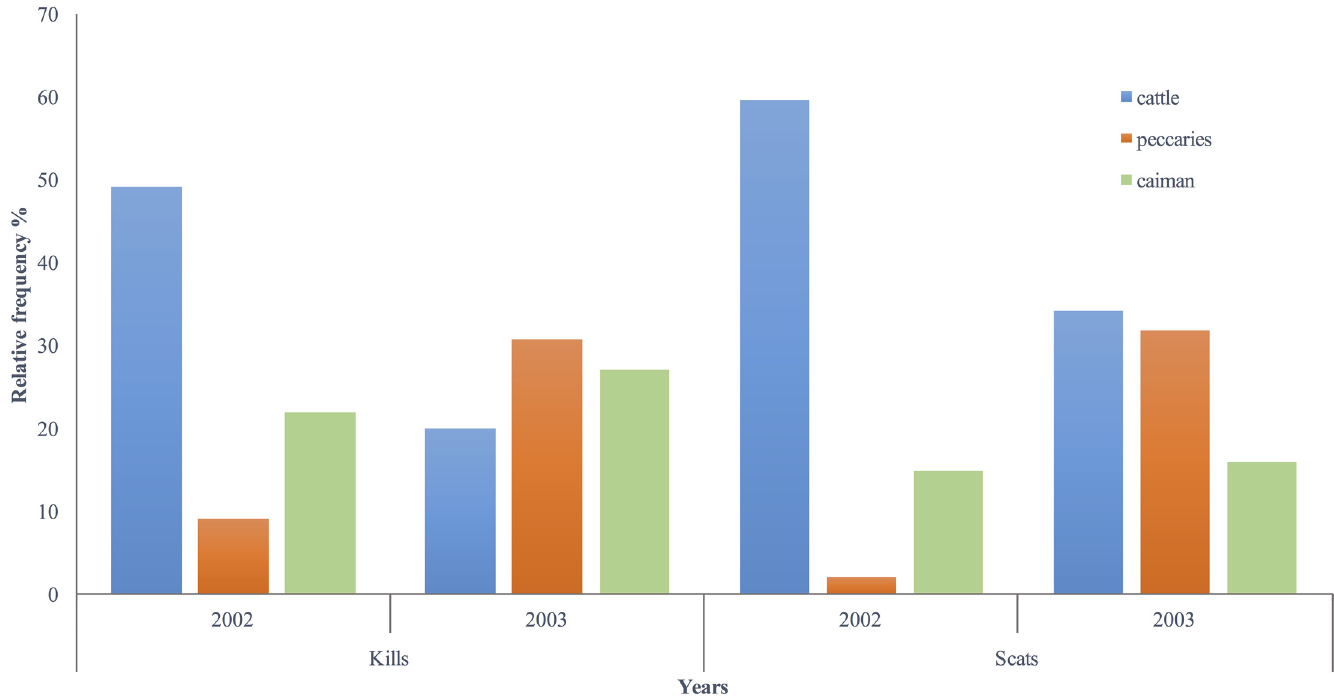
Fig 2. Relative frequency of occurrence of the 3 main prey found in GPS telemetry clusters of 10 radio-collared jaguars (Kills) and in 125 jaguar scats (Scats) during the years of 2001 and 2002. Southern Pantanal, Brazil.